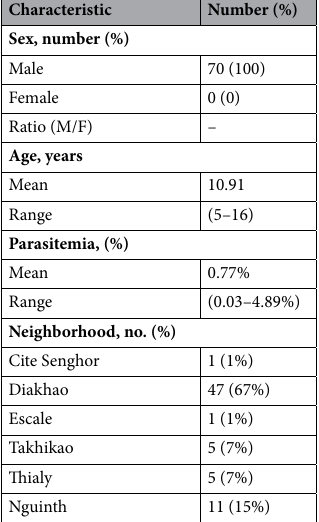
Table 1. Demographic characteristics of the study population. Patient demographics for the n = 70 participants. Sex, Age (in years), Parasitemia (calculated from thin smears), and breakdown of participants by neighborhood are